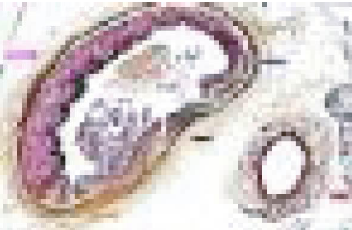
Figure 29: Vasospastic venous angiopathy. The red arrow points to a vein with irregular outer contours thickened by reparative alterations — edema, granulation tissue, and patchy loss of muscle in the adventitia. The adjacent artery (purple arrow) shows SAM induced change — transmedial granulation tissue (orange arrow), gap (black arrow), and a dissecting hematoma (blue arrow). Movat stain × 25 (adapted from the World Journal Cardiovascular Diseases 2013.3 published online).